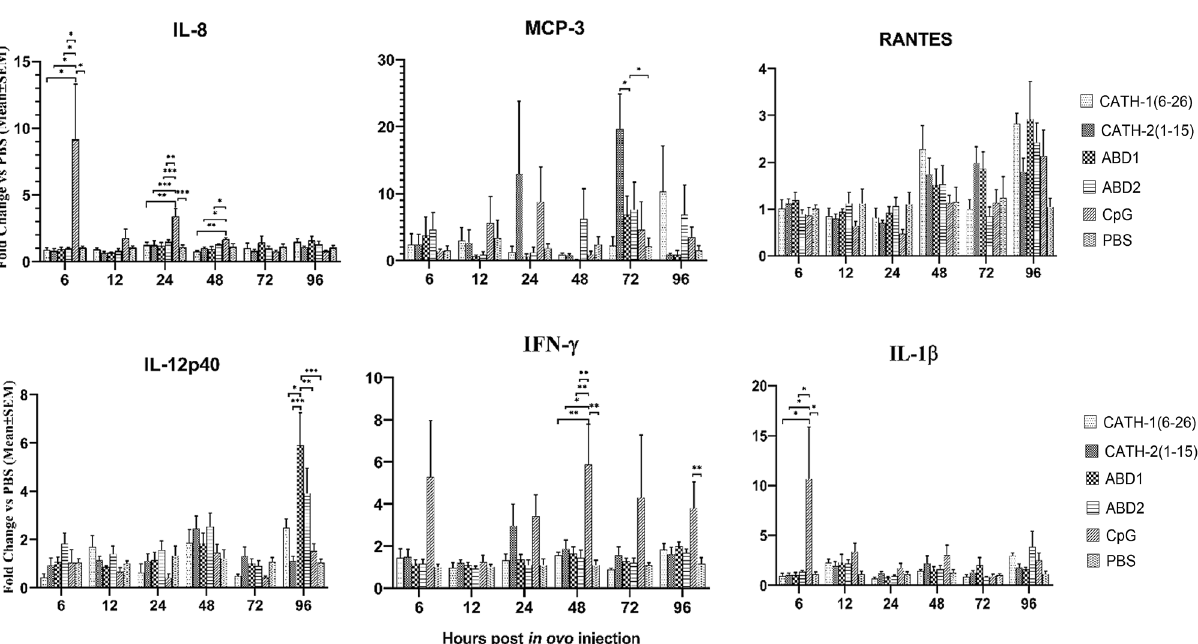
Figure 8. Expression of immune-related genes in spleen tissues post 6, 12, 24, 48, 72, 96 h in ovo treatment with peptides and CpG. Data represent means ± SEM. *, **, *** mean significantly different with p < 0.05; p < 0.01; p < 0.001,